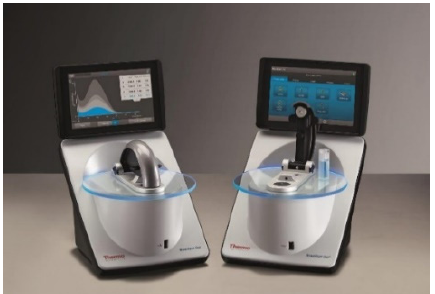
Figure 6. Nano spectrophotometer (NanoDrop).